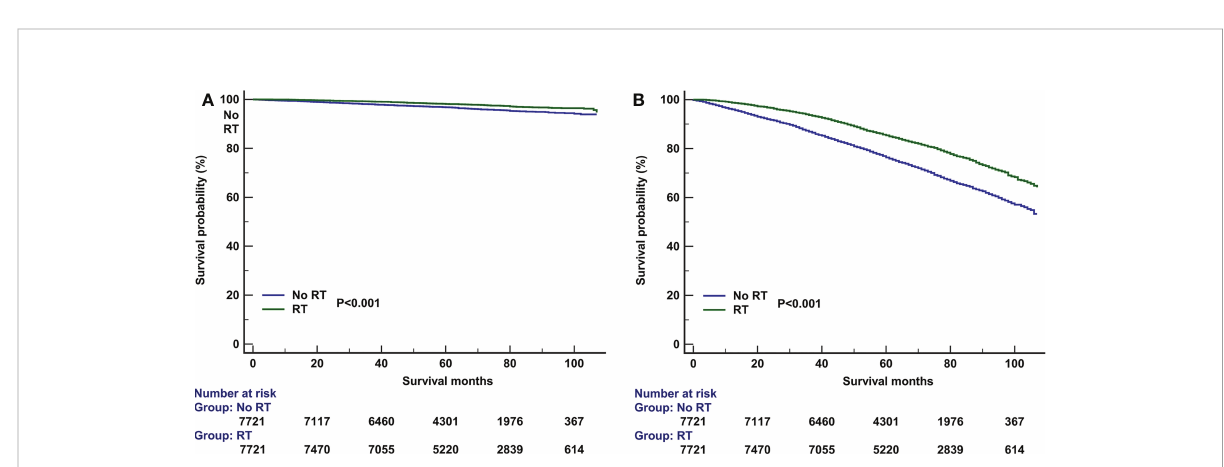
FIGURE 4 The effect of adjuvant radiotherapy on breast cancer-speci fi c survival (A) and overall survival (B) after propensity score